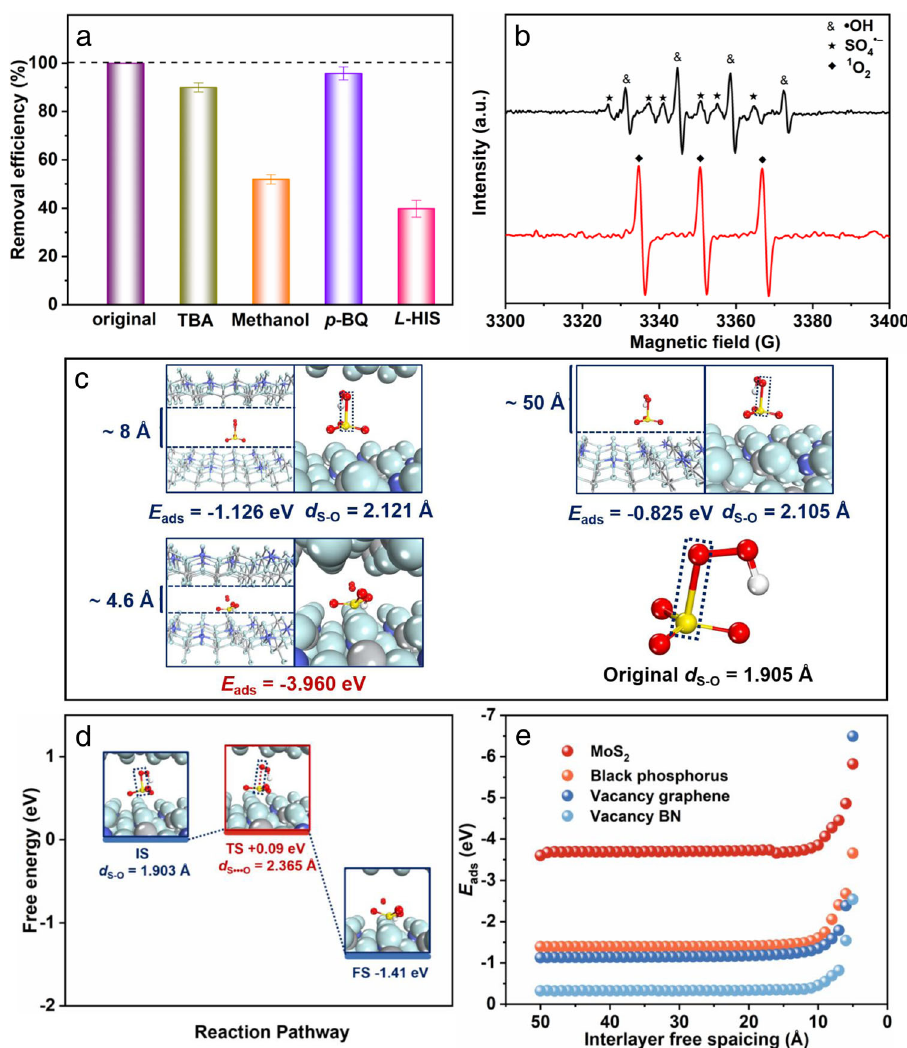
Fig. 4 Mechanism of angstrom-con fi nement catalysis performance of the Co-TiO x membrane and applicability to diverse material systems. a Comparison of the removal ef fi ciency under different quenching conditions. Error bars represent standard deviation of three measurements of quenching experiment. b EPR spectra of Co-TiO x membrane/PMS system. Reaction condition: [ranitidine] = 5 mg/L, [PMS] = 0.16 mM, [DMPO] = 0.35 mM, [TEMP] = 25 mM, initial solution pH = 4.0, and T = 298 K. c Energetic and geometric data of the models with representative interlayer free spacings. d Energy pro fi le during the dissociation of PMS within Co-TiO x membrane. e Adsorption energies of PMS molecule intercalating in other 2D nanosheet- assembled membranes with the varied interlayer free